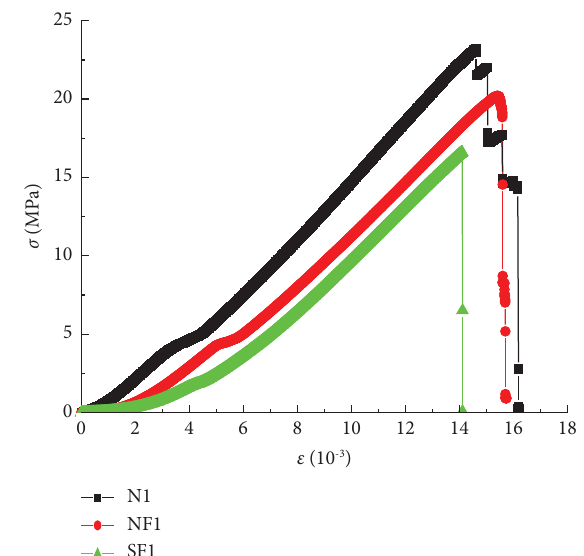
Figure 3: Stress-strain curves under diferent